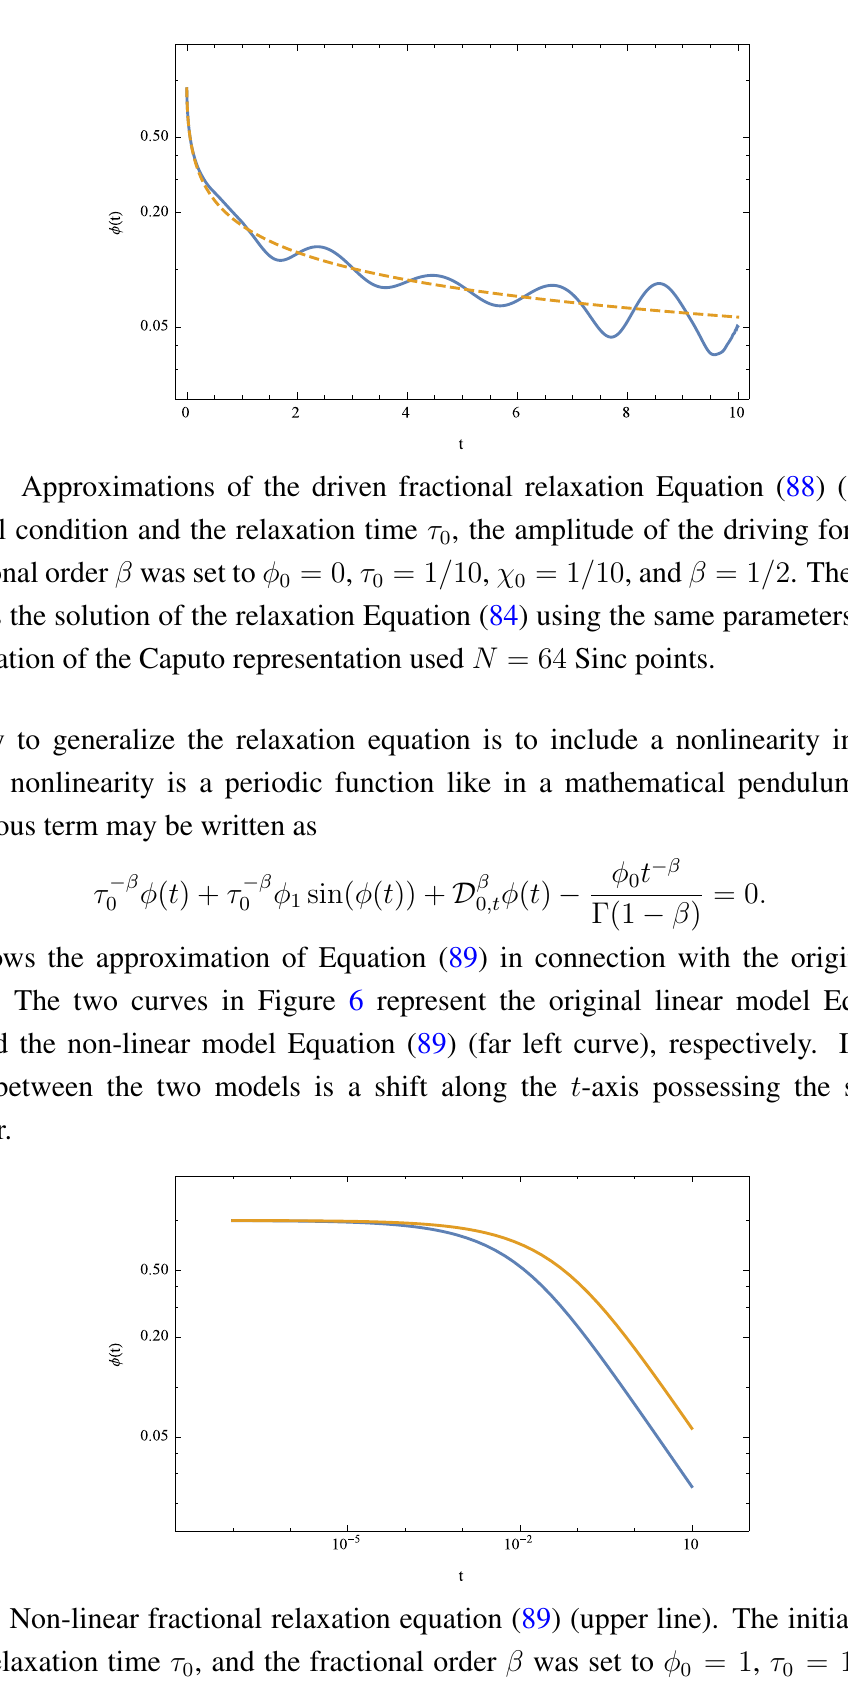
= 1 , (cid:28) = 1 = 10 , ϕ = 0 0 1